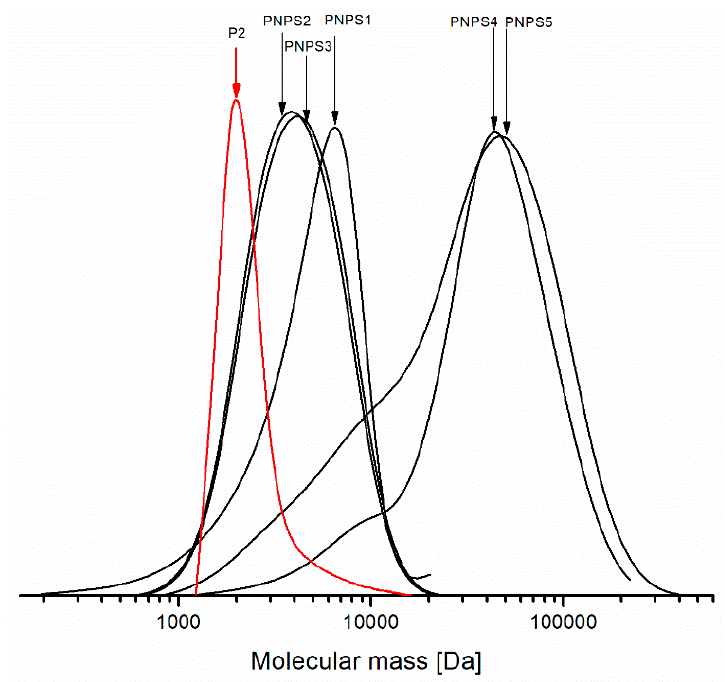
Figure 8. The molecular mass distribution obtained from the SEC analyses for the synthesized PNIPAM- b -PS copolymers (see a description of the samples in Table 3) and PNIPAM-Br (denoted in red) used as a macroinitiator for the preparation of PNPS2 and PNPS3.